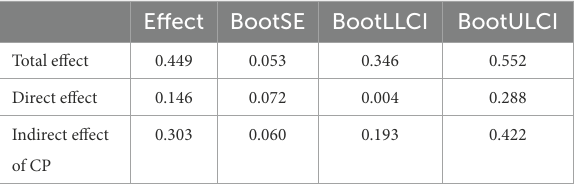
TABLE 3 Results of mediating effect analysis ( N =